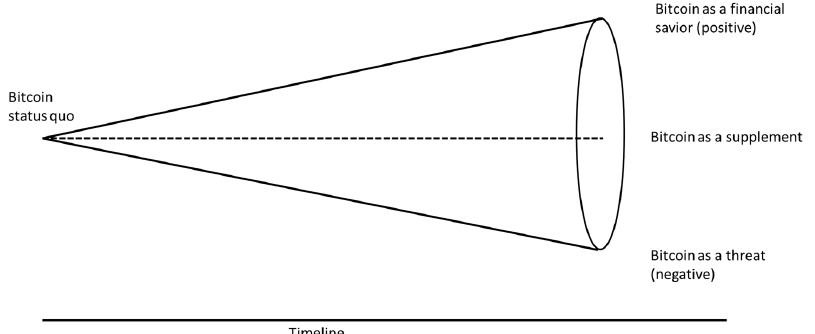
Figure 1. The scenario funnel for